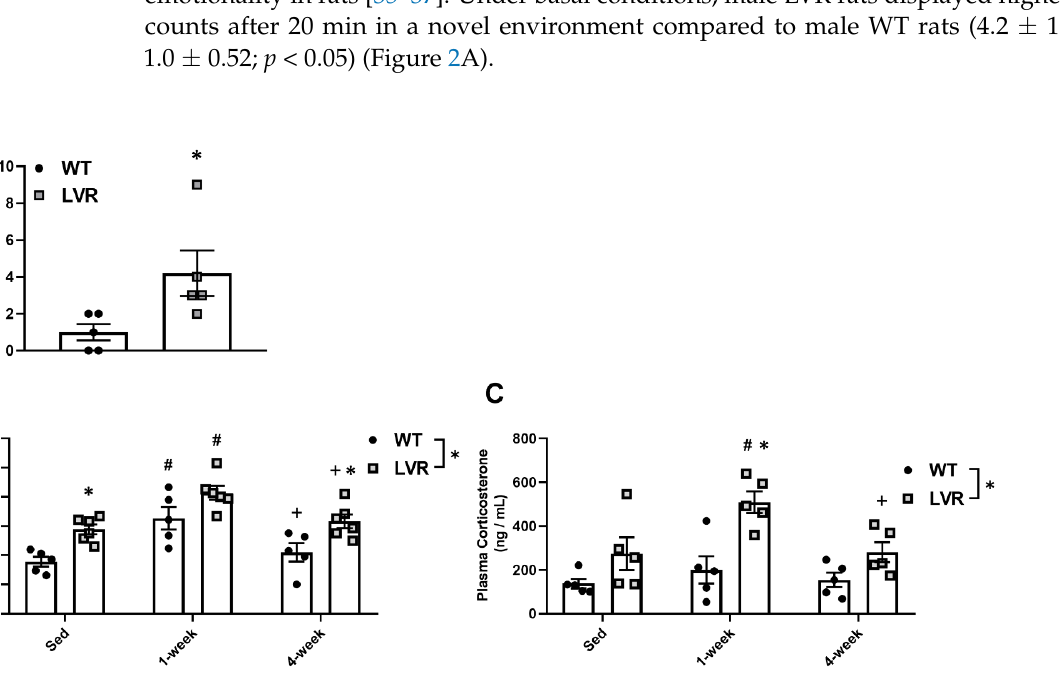
Figure 1. Phenotypic differences in wheel-running between wild-type (WT) (n = 5/running group; closed circles) and low voluntary runners (LVR) (n = 5–6/running group; gray squares) rats. ( A ) Average nightly running distances (km) for WT and LVR following 1 or 4weeks of voluntary wheel-access. ( B ) Average nightly running distance for WT rats that voluntarily ran for 1 or 4weeks. ( C ) Average nightly running distance for LVR rats that voluntarily ran for 1 or 4 weeks. * Denotes significant main effect ( p < 0.05) of strain ( A ) or significant difference ( p < 0.05) for Student’s t test ( B and C ). Values shown as mean ± SE.